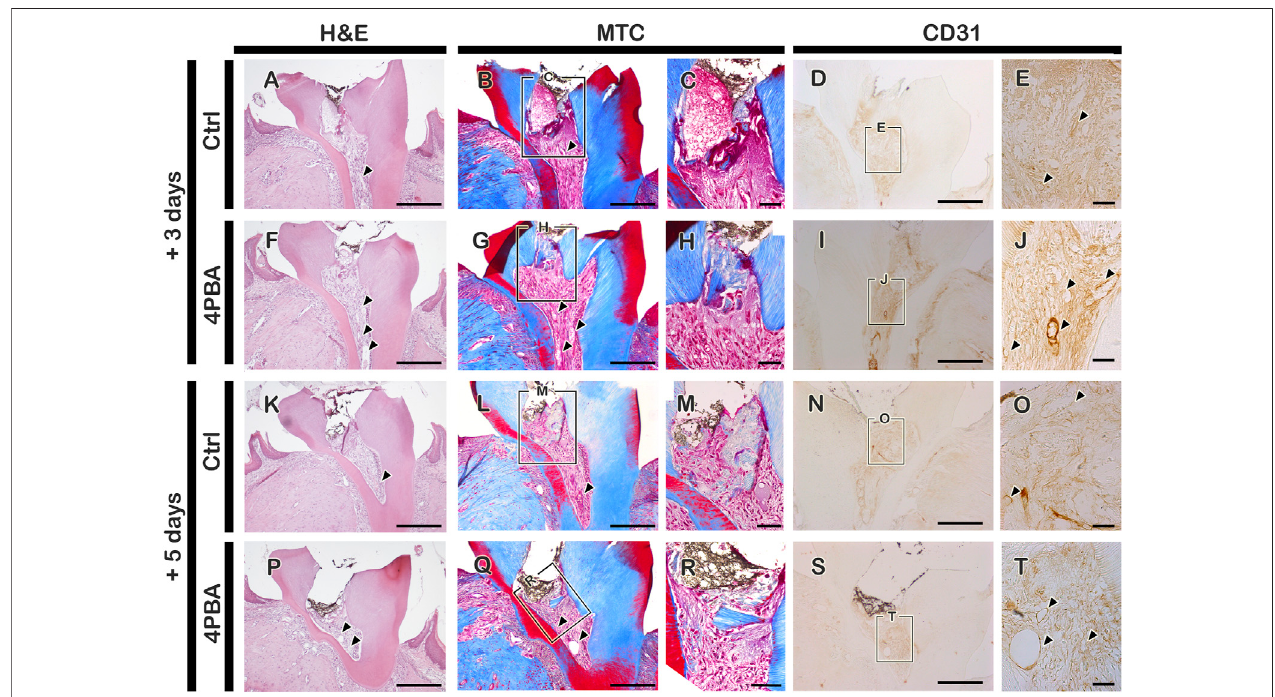
FIGURE2| HistologicalexaminationusingH&EandMTCstaining,andimmunostainingofCD31afterpulpaccesspreparation.Arrowheadindicatesbloodvessels (A-B, E, F-G, J, K-L, O, P-Q, T). Boxes in B, D, G, I, L, N, Q, S indicate enlarged view. Scale bars : A-B, D, F-G, I, K-L, N, P-Q, S: 200 μ m; C, E, H, J, M, O, R, T: 50 μ m.